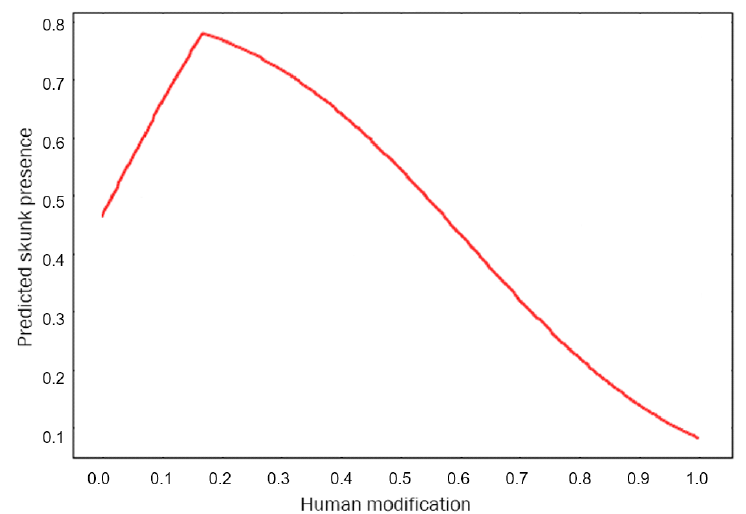
Figure 5. Predicted striped skunk presence as a function of human modification [41] based on striped skunk occurrences collected during January to April 2008–2010 and April 2018–March 2020. Highest probability (>75%) of striped skunk presence was found in areas with de- ciduous and mixed forests, especially in large, contiguous patches in the central portion of the study area (Figures 2–4). Developed open space often associated with maintained lawns and golf courses in the central portion of the study area also had high (>65%) striped skunk presence (Figures 2–4). Striped skunk presence was also highest in areas of moderate (0.1–0.4) [41] human modification often associated with exurban and fragmented forest (Figures 1, 3 and